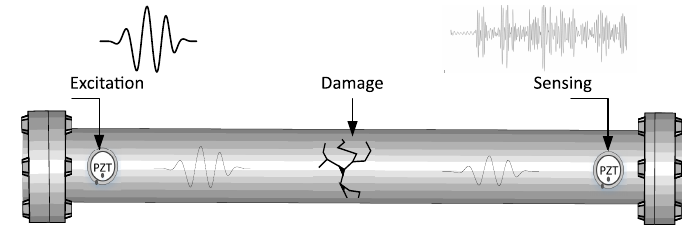
Figure 2. Piezo-diagnostics principle